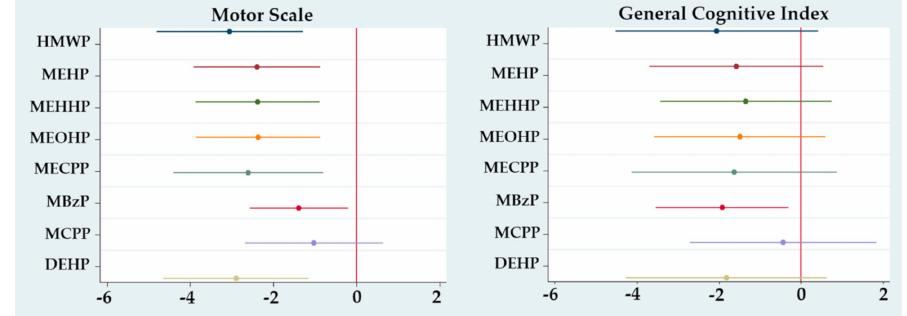
Figure 1. Regression coe ffi cients for change in McCarthy Scales of Children’s Abilities (MSCA) associated with a first trimester ln-unit increase in urinary phthalate metabolite concentration, adjusted for sex, gestational age, breastfeeding and maternal IQ. *Motor Scale: only MCPP p > 0.05; General Cognitive Index: only MBzP p <